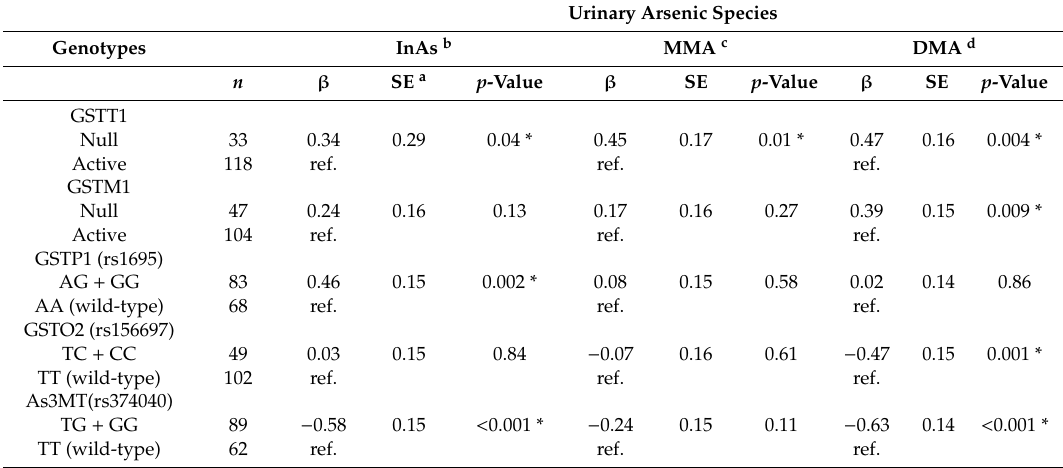
Table 3. Univariate analyses of demographic characteristics and lifestyle on urinary arsenic metabolites. Urinary Arsenic Species Covariates InAs b MMA c DMA d n β SE a p -Value TAs in water ( µ g / L), median (range) 26.1 (10,39.4) 0.31 Urinary TuAs e ( µ g / g creat.), median (range) 4.0 (2.7,7.0) Age (years), mean ± SD